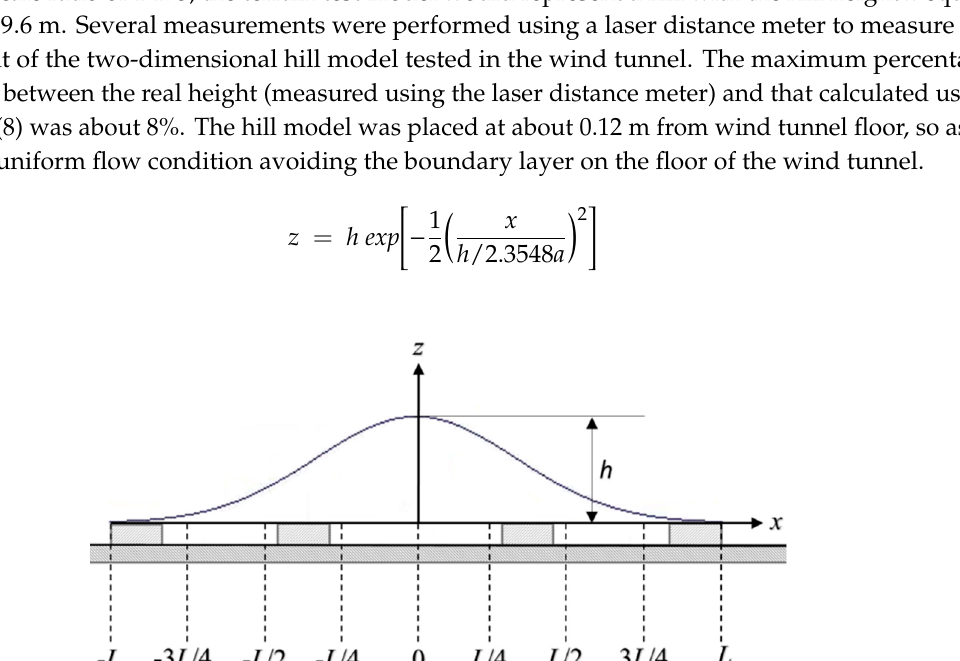
Table 1. Measurement locations of wind speed profiles along the x -axis.